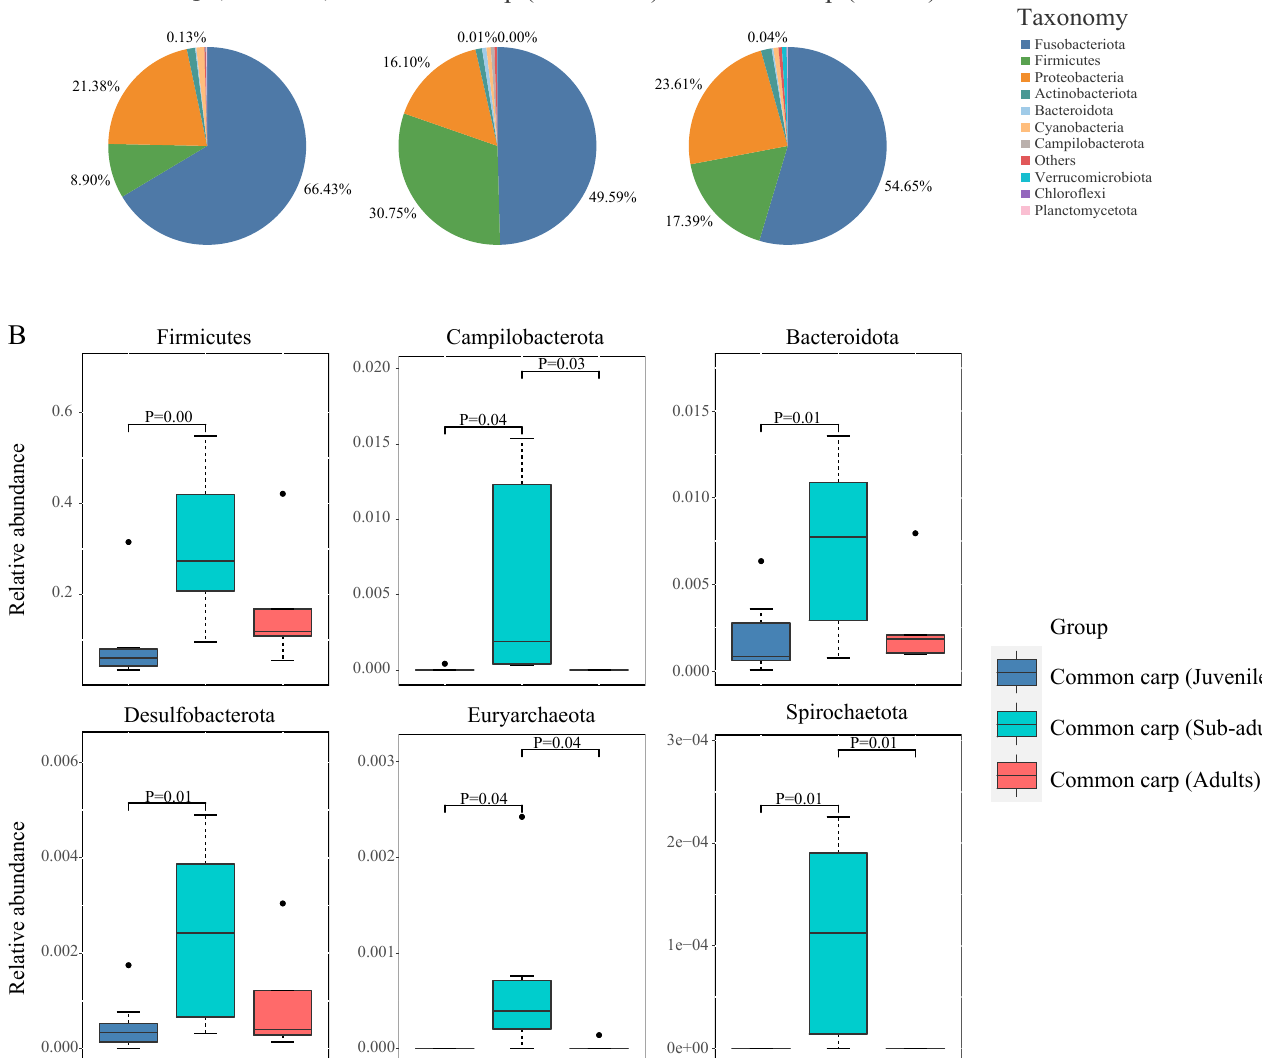
Figure 3. Gut microbial composition of the common carp during three different developmental stages (juvenile, sub-adult, and adult). ( A ) Pie chart for the relative abundance of the top 10 bacterial phyla in GI tracts of common carp during three different developmental stages, ( B ) Box-and-whisker plots for the relative abundance of six bacterial phyla with significant differences ( p < 0.05) across the three developmental